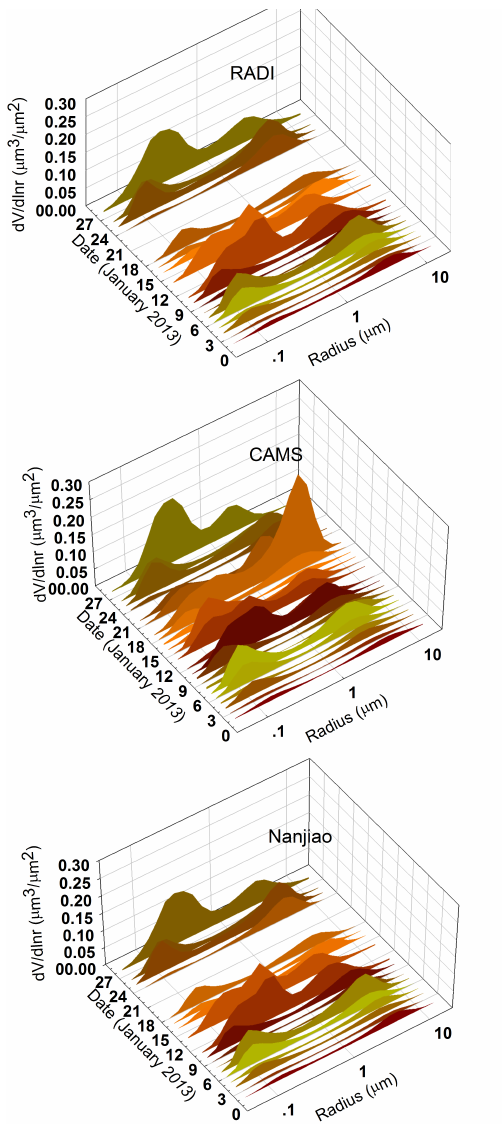
Fig. 5. Waterfall plots of daily aerosol volume size distribution dur- ing January 2013 at the three urban sites of RADI, CAMS and Nan- jiao, located in